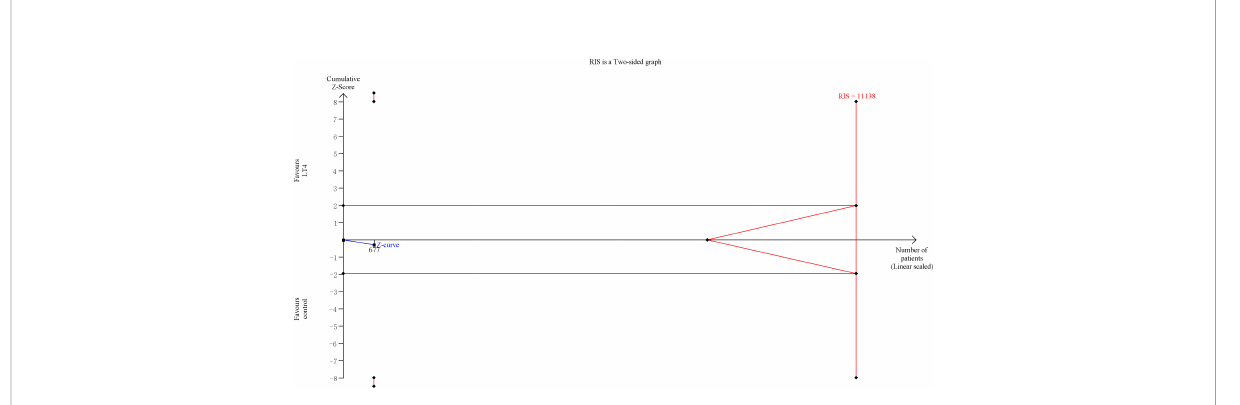
FIGURE 5 Trial sequential analysis of preeclampsia. The risk of type I error was set at 5% with a power of 80%. The variance was calculated from the data obtained from the included trials. The relative risk reduction (RRR) was set at